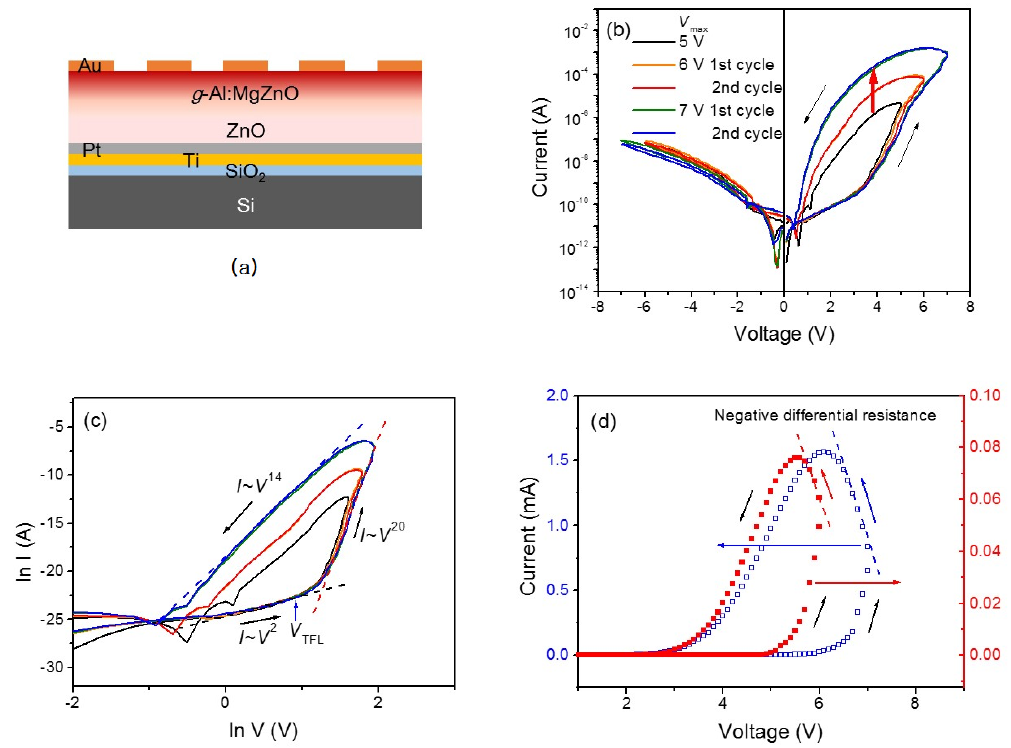
Figure 4. ( a ) Metal-semiconductor-metal (MIM) structure of device based on g -Al:MgZnO/ZnO heterostructure film; ( b ) I - V characteristics of the device with different V max with a voltage sweep from 0 V to + V max , + V max to − V max followed by − V max to 0 V; ( c ) the logarithmic plots of the I - V curves showing a power-law dependence, I ~ V α ; ( d ) negative differential resistance around V max upon changing the voltage sweep direction to dV/dt < 0.